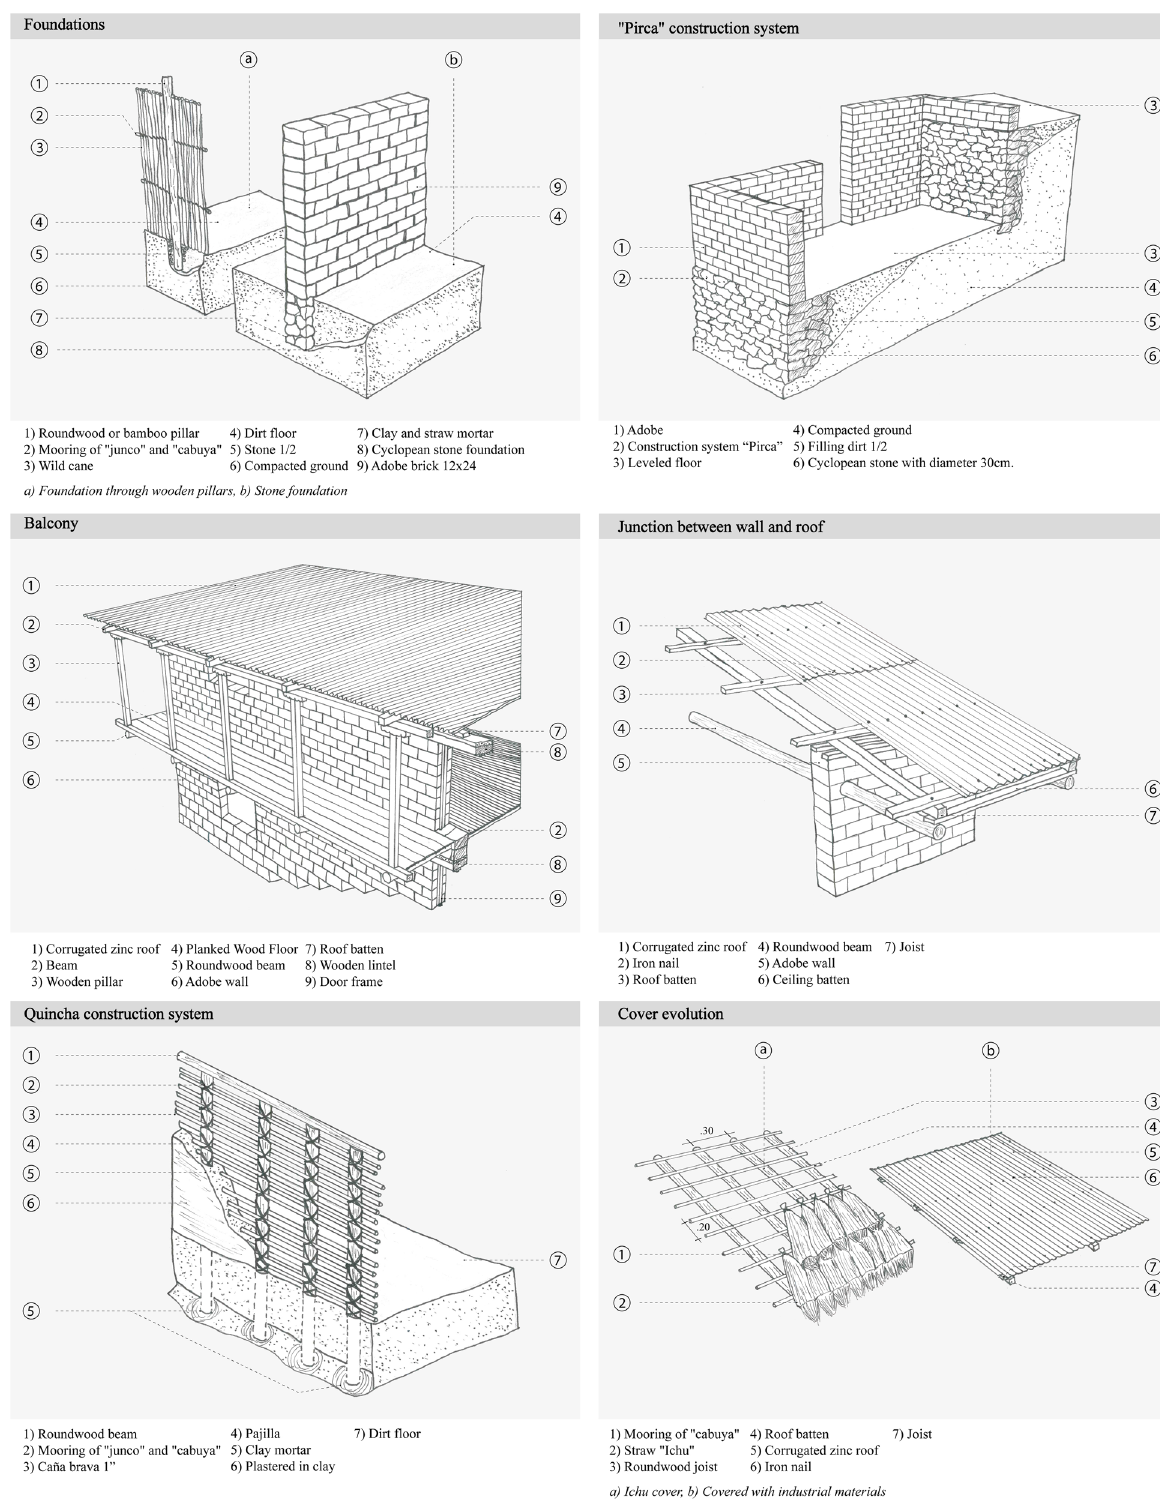
Fig. 8 Construction details of rural housing in Jaén. (Source: the